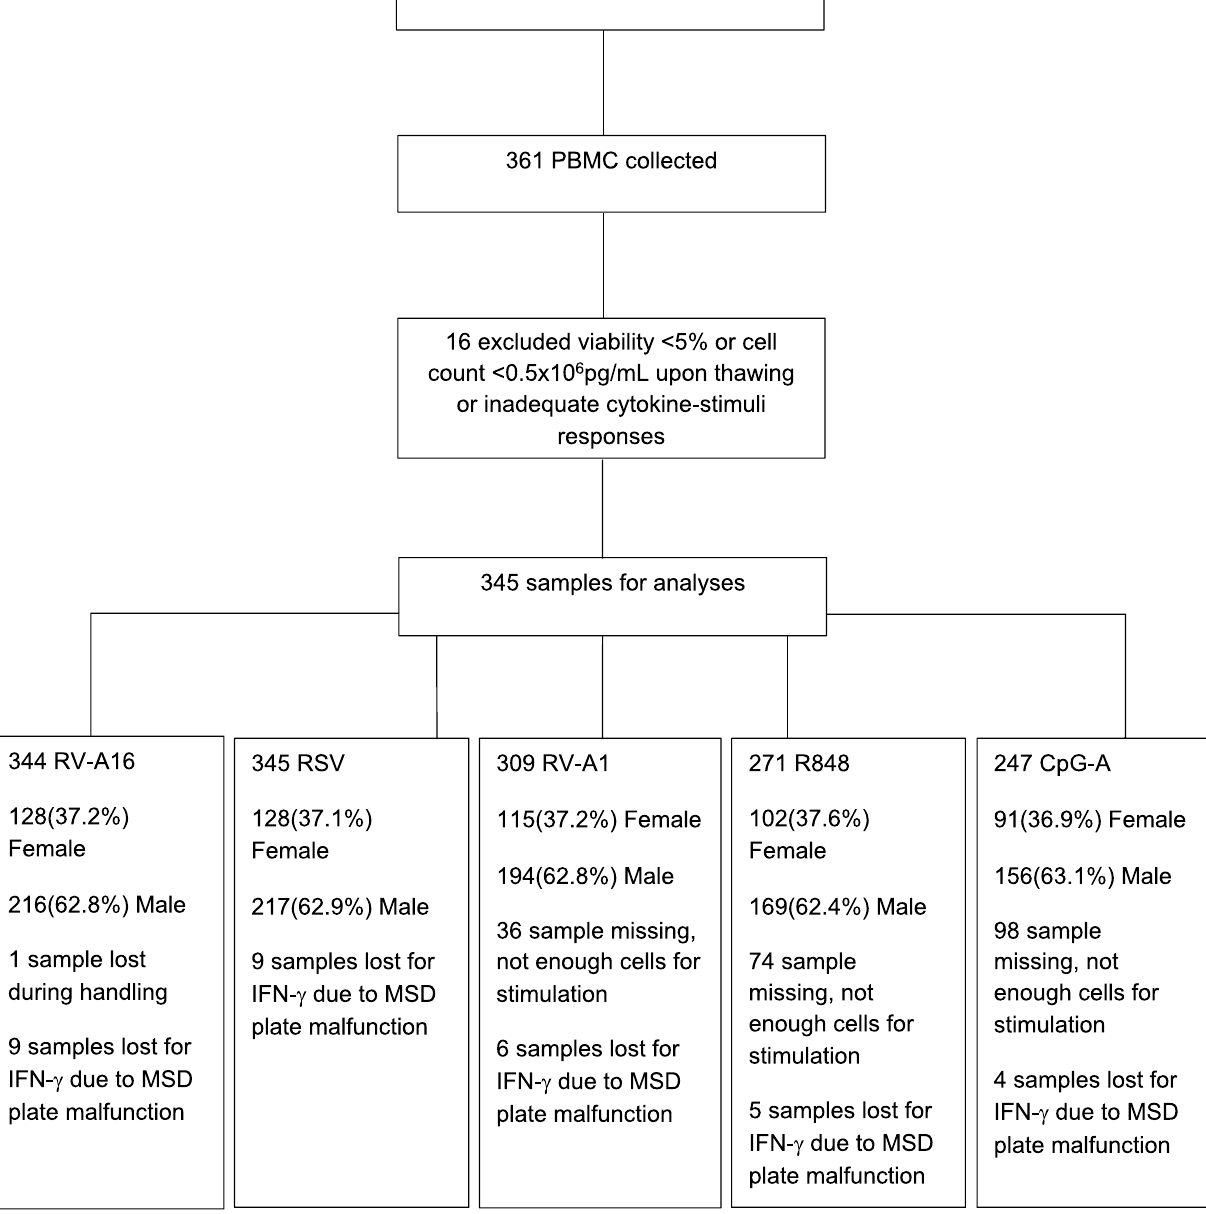
Figure 1. Participant flow and PBMC stimulation numbers for each stimulus at age 16